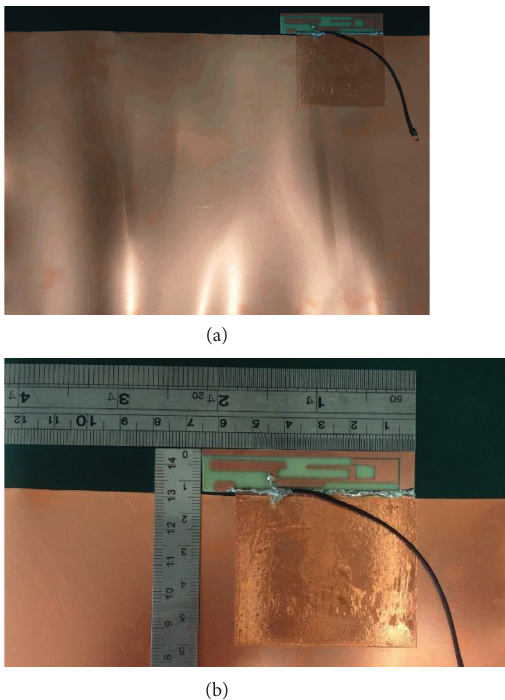
Figure 2: Prototype